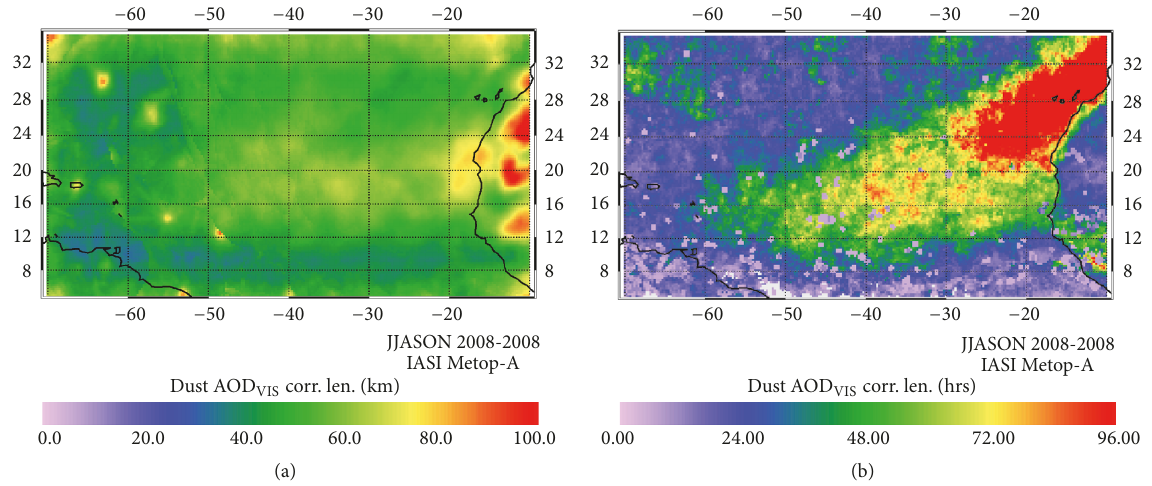
Figure 3: Spatial (a) and temporal (b) correlation lengths for desert dust retrieved from IASI with the IMARS method over the tropical North Atlantic Ocean. IASI observations of the entire hurricane season (JJASON) 2008 are used for the assessment.